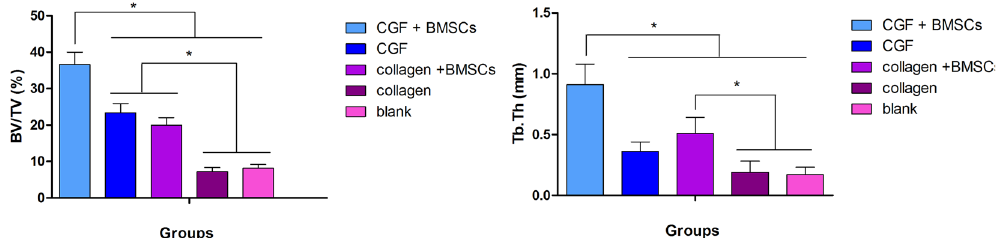
Figure 6. New bone formation analysis of BV/TV and Tb.Th among five groups at 6 weeks postoperation. * Indicates significant differences between each groups, p <